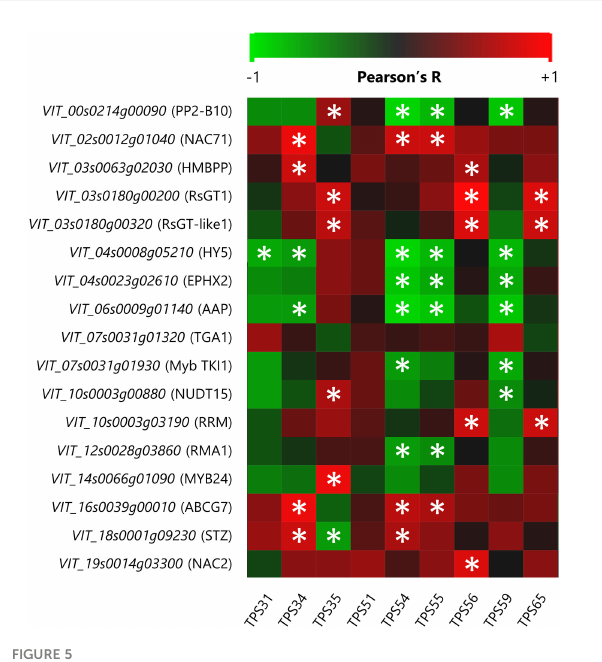
FIGURE 5 Pearson ’ s correlation heatmap between putative genes proposed for regulating the terpenes biosynthesis and monoterpenes synthases genes in berries of Sangiovese grapevines ( Vitis vinifera L.) subjected to different irrigation regimes (FI, full irrigation from berry pea size to harvest; RDI-LS, water de fi cit applied during lag phase; RDI-1S and RDI-1M, severe and moderate water de fi cit applied from berry pea size to beginning of veraison; RDI-2S and RDI-2M, severe and